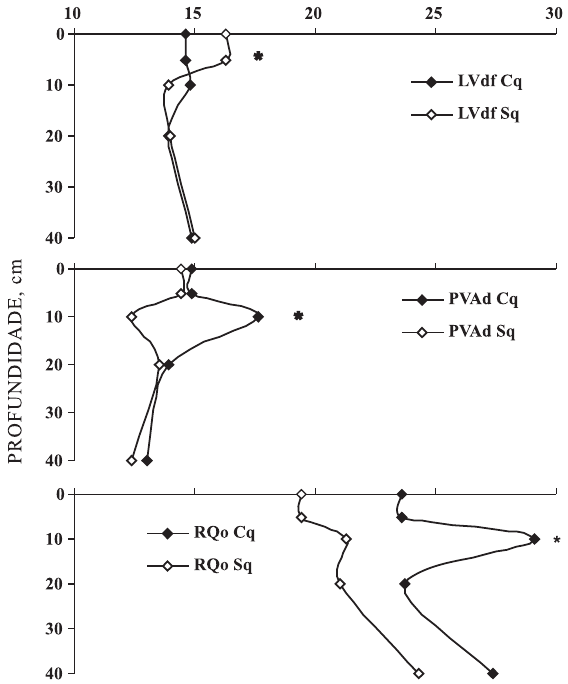
Figura 2. Relação C/N do Latossolo Vermelho distroférrico (LVdf), Argissolo Vermelho- Amarelo distrófico (PVAd) e Neossolo Quartzarênico órtico (RQo) sob os manejos com queima (Cq) e sem queima (Sq) de canavial nas diferentes profundidades. * Diferença estatística entre tratamentos na mesma profundidade, de acordo com o teste t